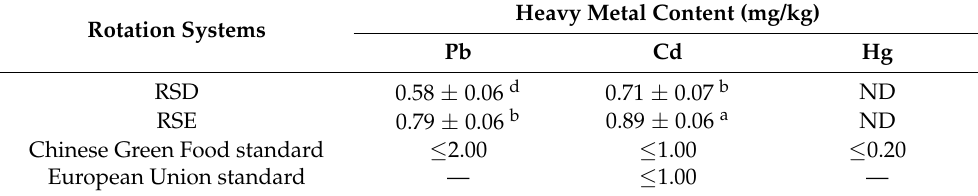
Figure 8. Effect of different rotation systems on essential amino acid indexes, biological values, and nutritional indexes of M. importuna . EAAI, essential amino acid indexes; BV, biological values; NI, nutrition indexes.